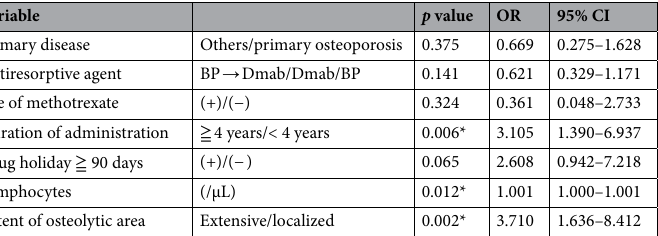
Variable Primary